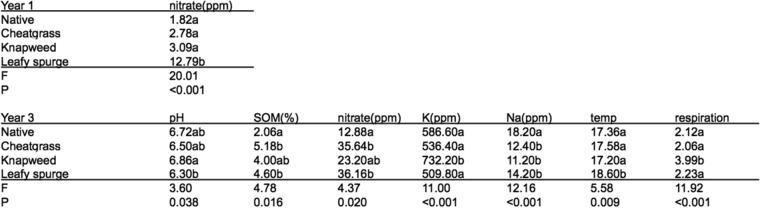
Results from ANOVA showing significant differences in soil physicochemical variables in the experimental plots for year 1 and year 3. Letters (i.e., a and b) denote significant groupings based on Tukey's post hoc test.